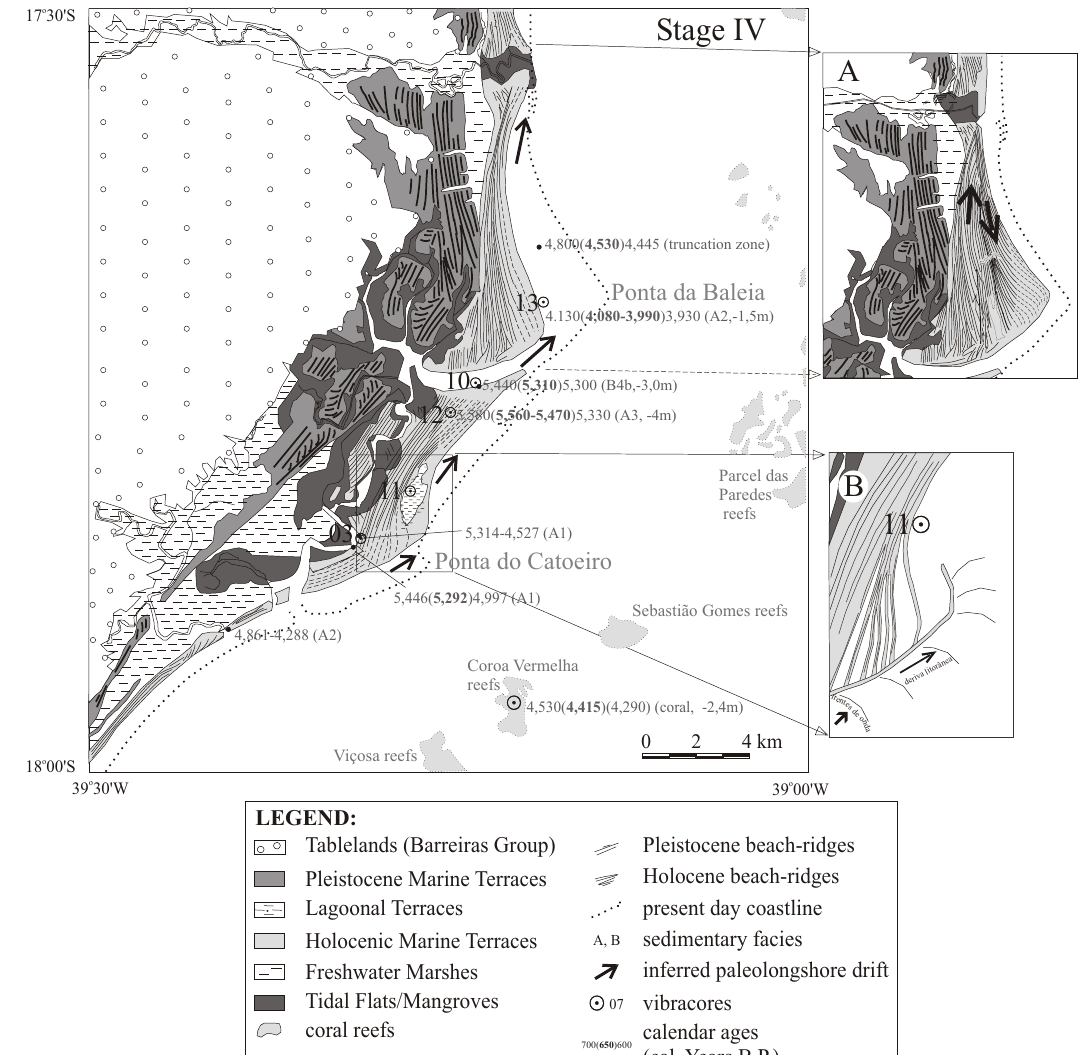
Fig. 12 – Quaternary evolution of the Caravelas strandplain: Stage IV – Beginning of the sedimentation in the northearn sector of the Caravelas